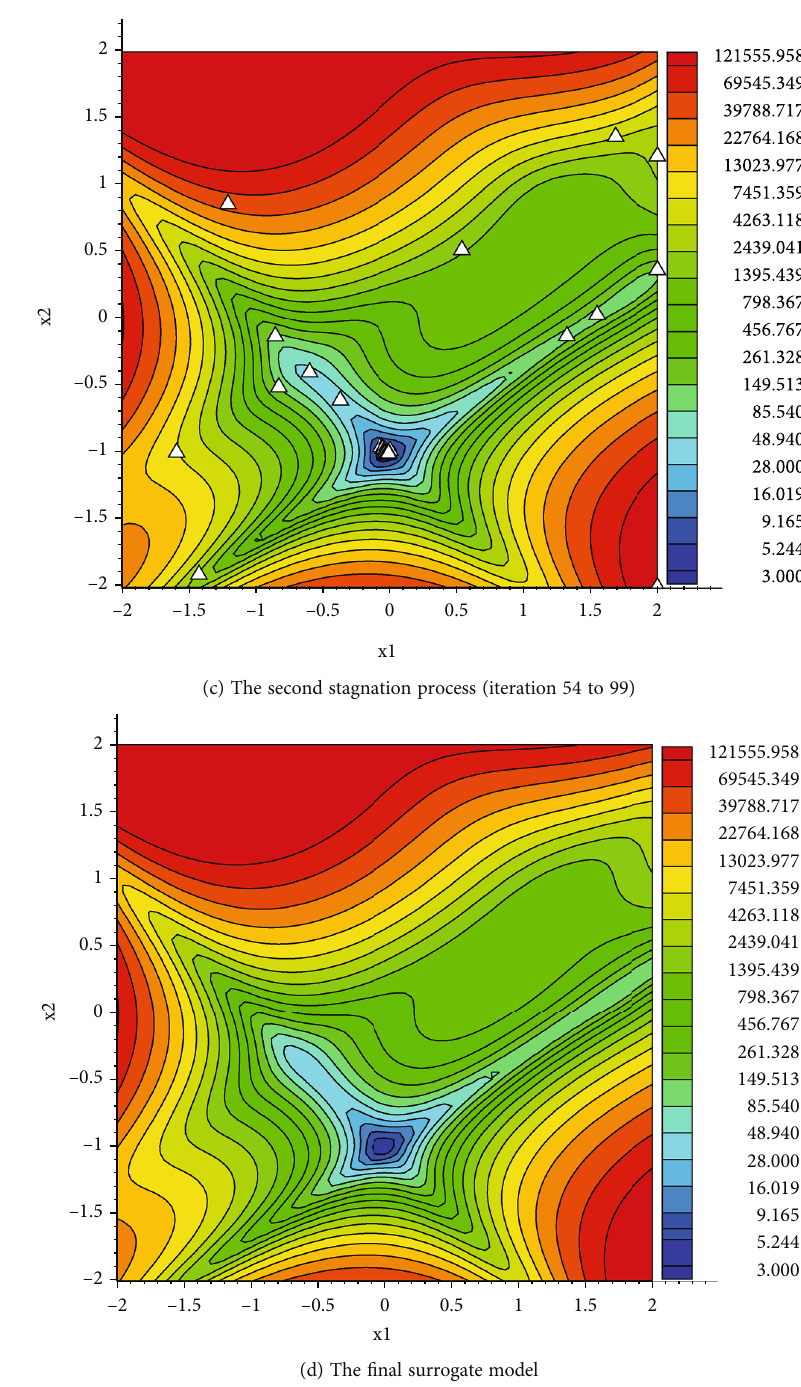
Figure 7: The in fi ll process of the EGO